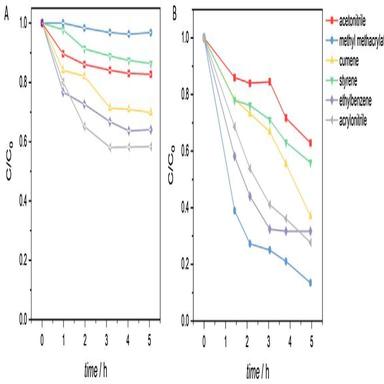
The photocatalytic degradation of VOCs generated by operating 3D printer. Degradation curves of under irradiation by λ = 400 nm LED in the presence of g-C3N4 (A) or Sb/ g-C3N4 (B).